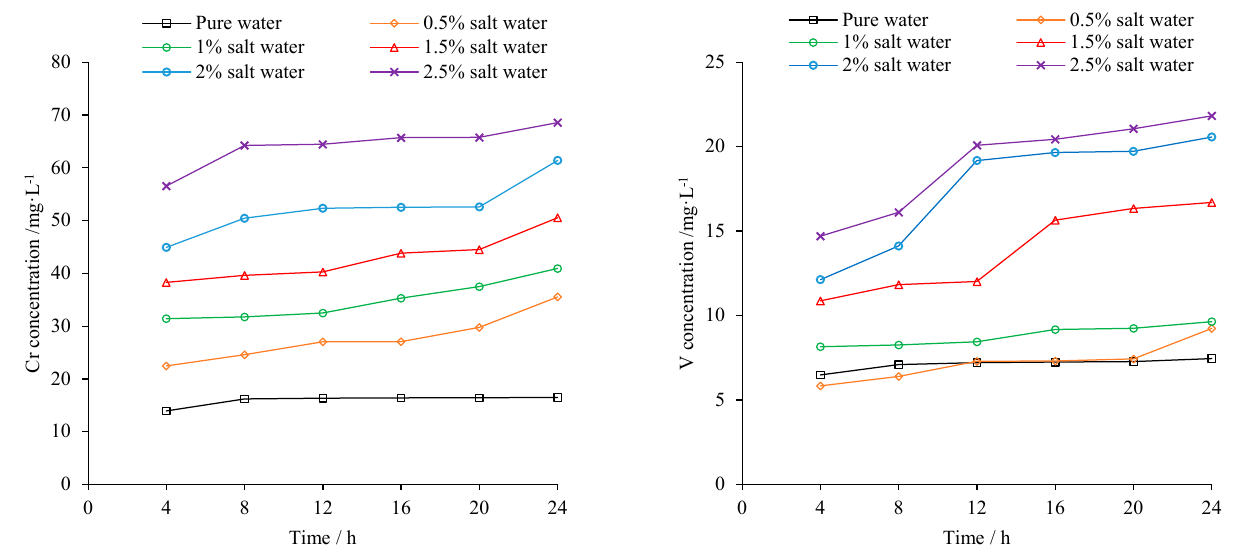
Figure 14. Heavy metal precipitation at different salinity.